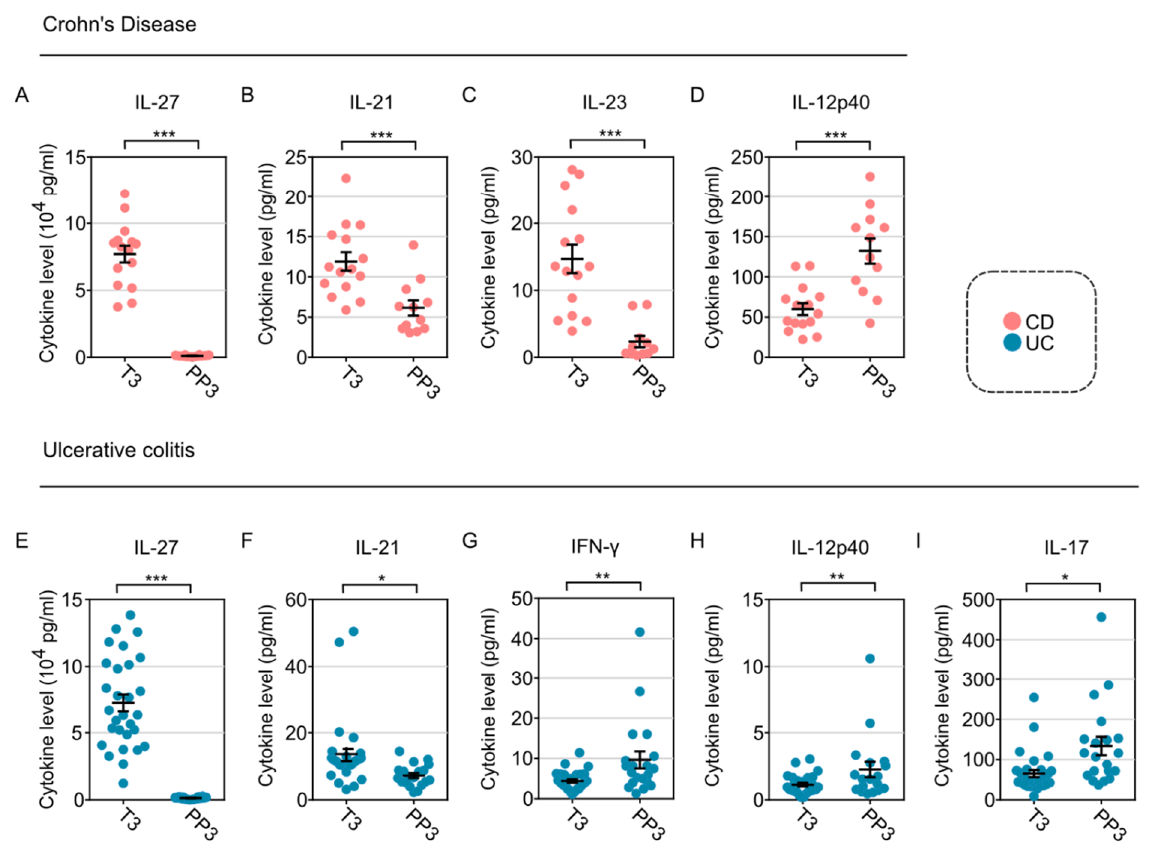
Figure 3. Cytokine changes altered by delivery in women with IBD. ( A ) IL-27, ( B ) IL-21, ( C ) IL-23, and ( D ) IL − 12p40 were significantly altered between trimester 3 and post-partum month 3 in women with CD (N = 16–21 patients per cytokine tested). ( E ) IL-27, ( F ) IL-21, ( G ) IFN- γ , ( H ) IL-12p40, and ( I ) IL-17 were significantly altered between trimester 3 and post-partum month 3 in women with UC (N = 20–25 patients per cytokine tested). T3 denotes trimester 3 and PP3 signifies post-partum month 3. * signifies p < 0.05, ** signifies p < 0.01, and *** denotes p < 0.001 using unpaired Student’s t -test.